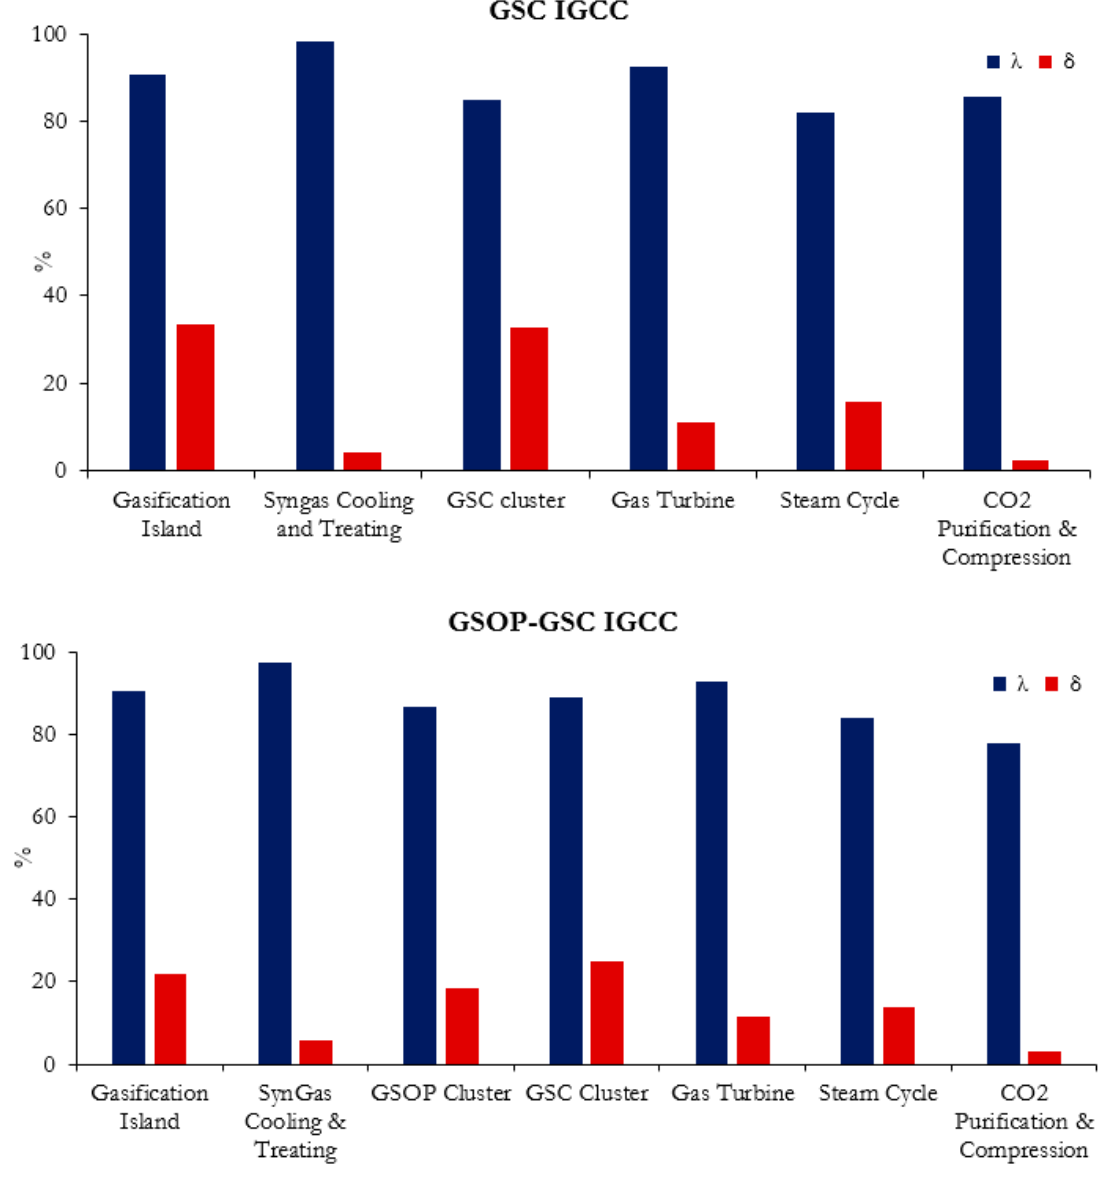
Figure 9. Exergy utilization λ and exergy destruction contribution δ in percent for the gas switching (GS) power plants, as defined by Equations (4) and (5).